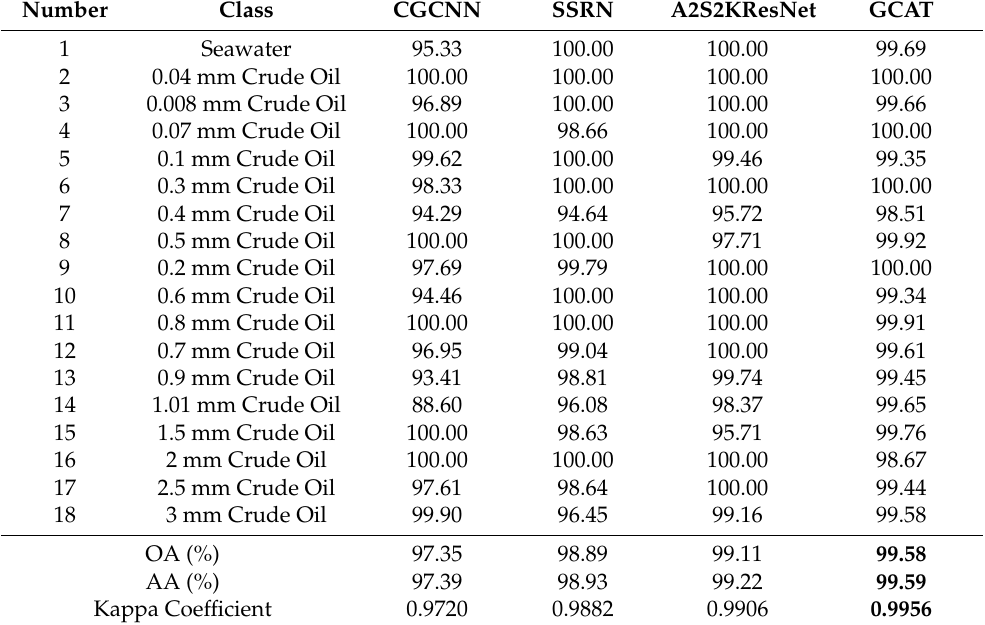
Table 5. Classification results of different methods for the oil film thickness